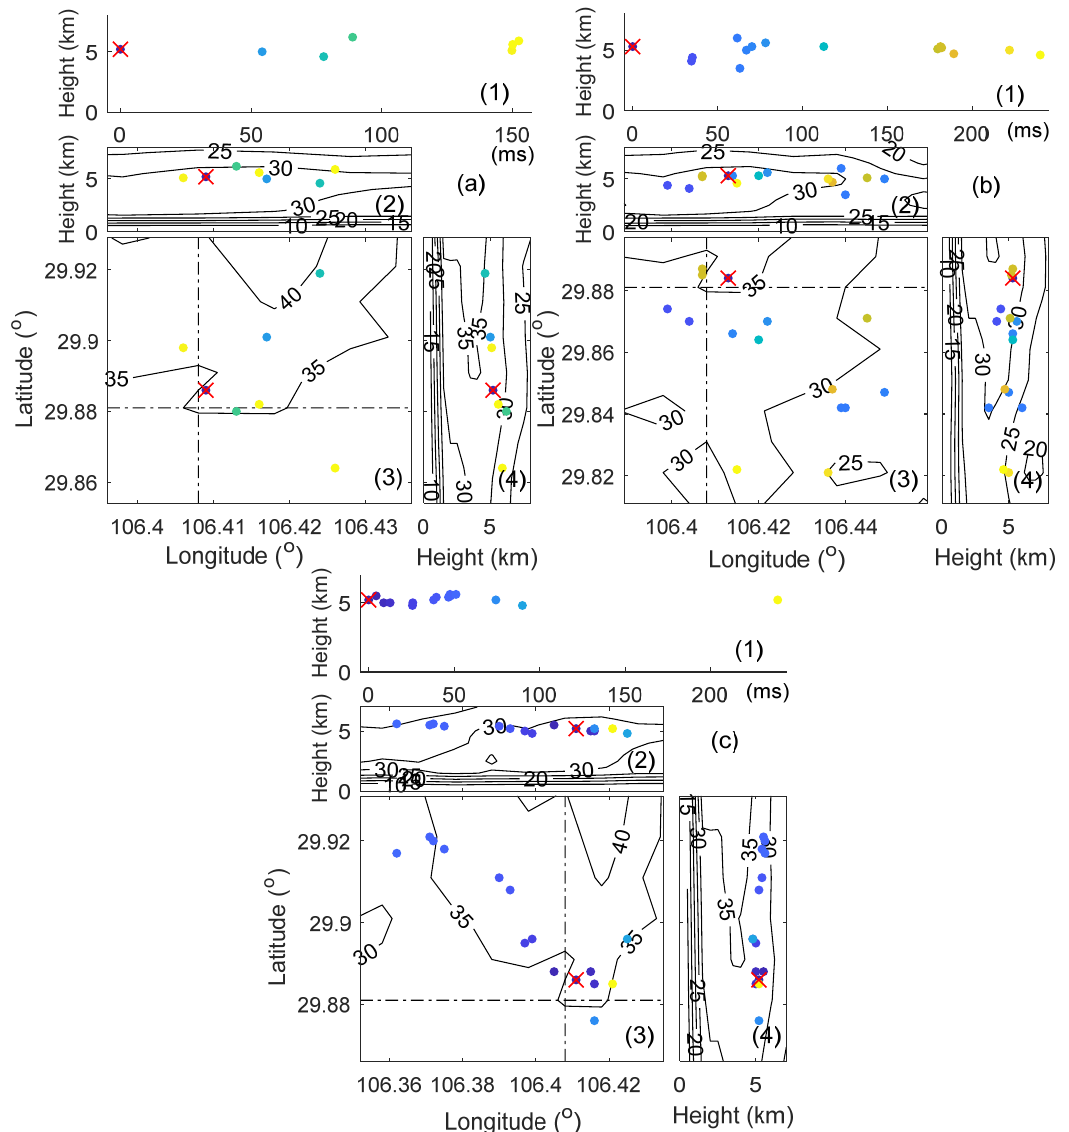
Figure 8. Similar to Figure 6, but for lightning flashes initiated in the SD grid of Figure 5a at a lower level. The flashes in ( a – c ) were initiated at 19:02:00.927, 19:02:44.607, and 19:03:24.744 CST, respec- tively.